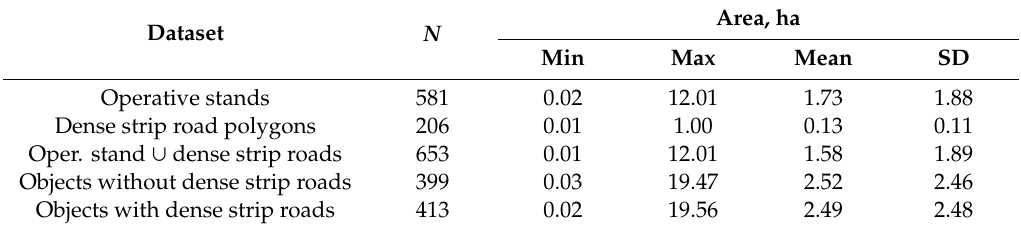
Table 2. The numbers ( N ) and areas of harvested tree stems for harvested stands, strip roads leading to stands and harvested objects. Note that the hold-over cuttings were excluded. The numerically estimated GNSS accuracies were used. Abbreviation: SD, standard